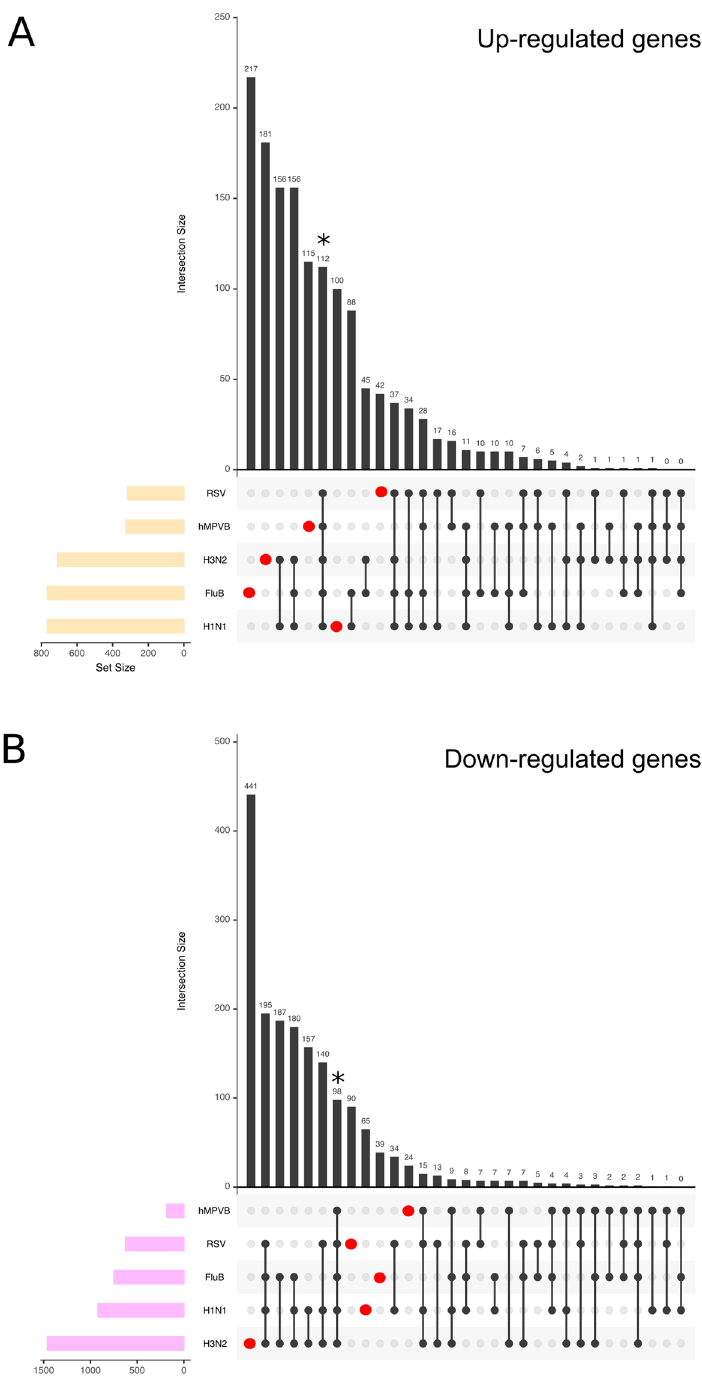
Figure 4. Intersections among host-infected signatures. Differential gene expression was calculated with a p-value threshold < 0.05 and an absolute fold-change > 2. Intersections among five viral signatures are shown. Panel A accounts for up-regulated genes and panel B for the down-regulated ones. The matrix of solid black or grey circles at the bottom illustrates the “presence” (black circle) or “absence” (grey circle) of the gene sets in each intersection. The numbers to the left of the matrix are set sizes. The colored bars on the top of the matrix represent the intersection sizes. hRSV and hMPV infections account for a lower number of genes differentially expressed and the H3N2 down-regulate the highest number of genes ( > 1000). 112 and 98 genes (black star) were commonly modulated in all infection studied but each infection also accounted for specific gene modulation (represented in red